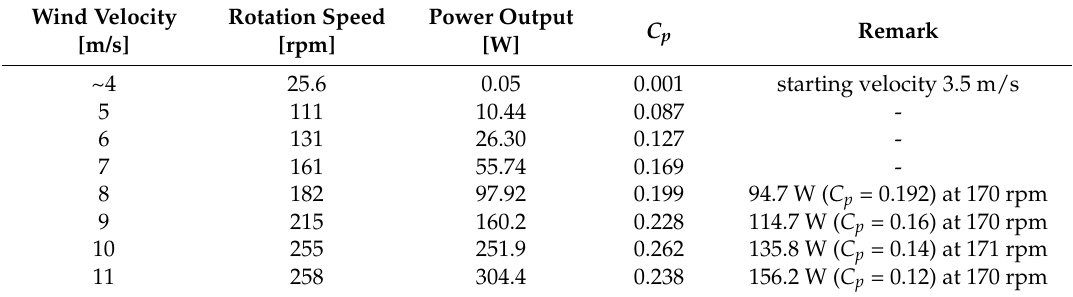
Table 6. Power output and power coefficient according to wind velocity obtained from wind tunnel